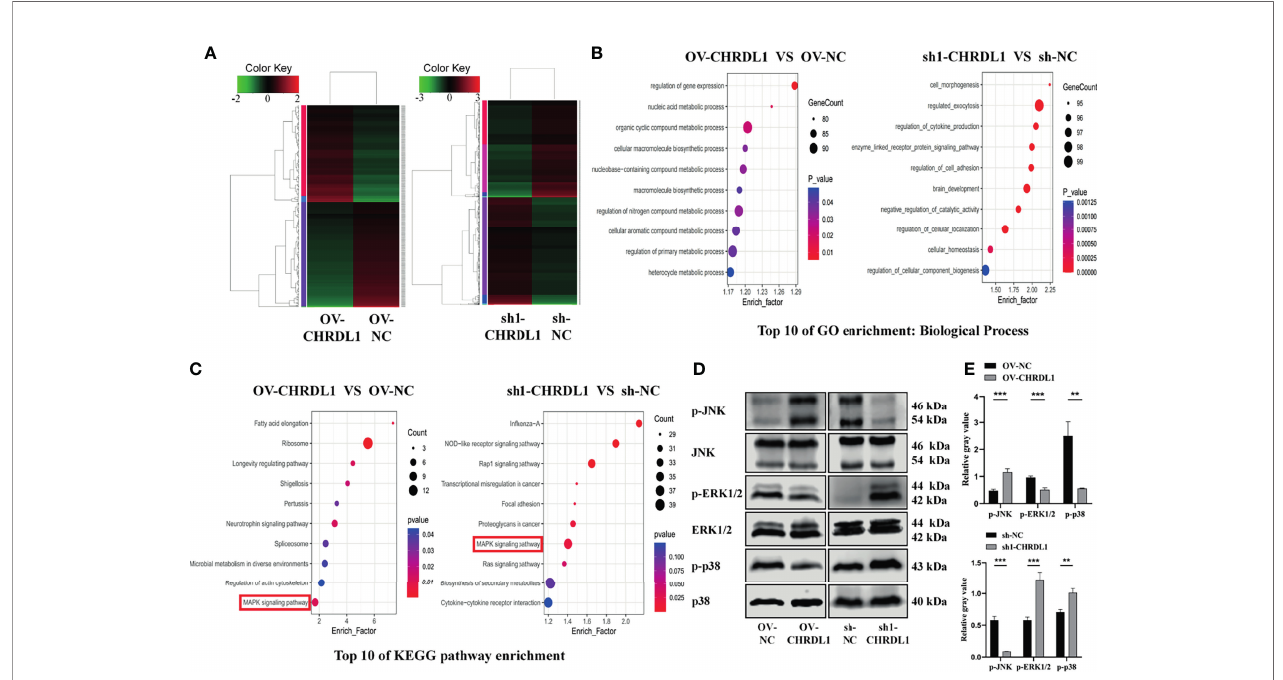
FIGURE 5 | CHRDL1 regulates the MAPK signaling pathway in CAL27 cells. (A) Heatmap of differentially expressed genes between OV-CHRDL1 and OV-NC (left) and between sh1-CHRDL1 and sh-NC (right). Green indicates downregulated genes, and red indicates upregulated genes. The thresholds for up- and downregulation were a +2.0-fold and -2.0-fold change, respectively, and a p adj < 0.05. (B) Top 10 GO-BP terms enriched among DEGs from OV-CHRDL1 CAL27 cells and sh1-CHRDL1 CAL27 cells. (C) Top 10 KEGG pathways enriched among DEGs from OV-CHRDL1 CAL27 cells and sh1-CHRDL1 CAL27 cells. (D, E) Protein expression of MAPK signaling pathway-related markers in CAL27 cells after lentivirus transfection. Error bars represent the standard deviation. ** p < 0.01, *** p <